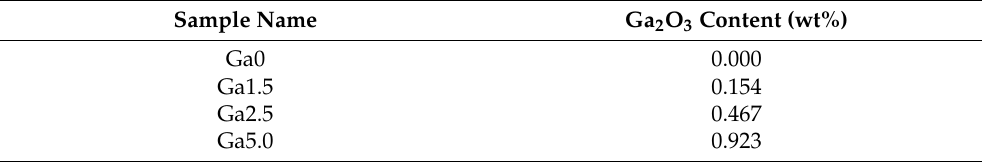
Table 5. Ga 2 O 3 content of each